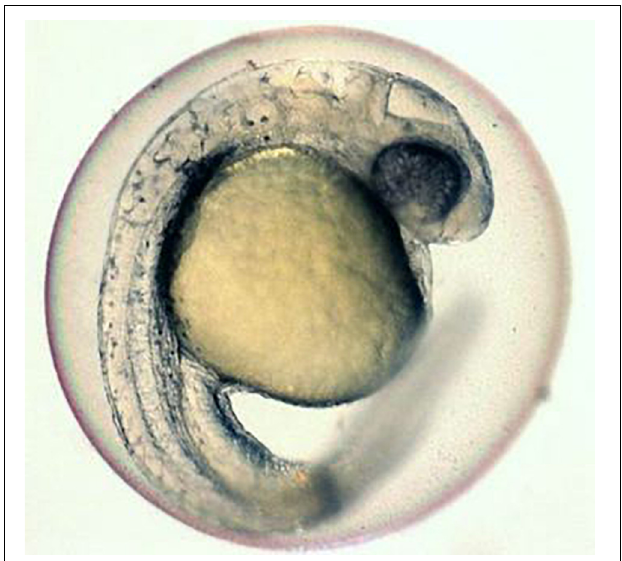
FIGURE 1 | Zebra fish embryo cryopreservation by using gold nano-particles and laser. Source: (University of Guelph published in ACS Nano).